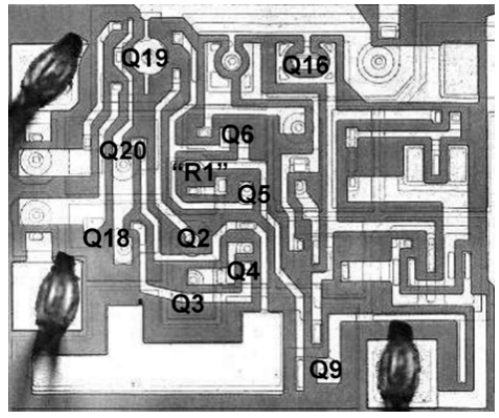
Figure 5. Location distribution of the SET sensitive transistors of LM124.